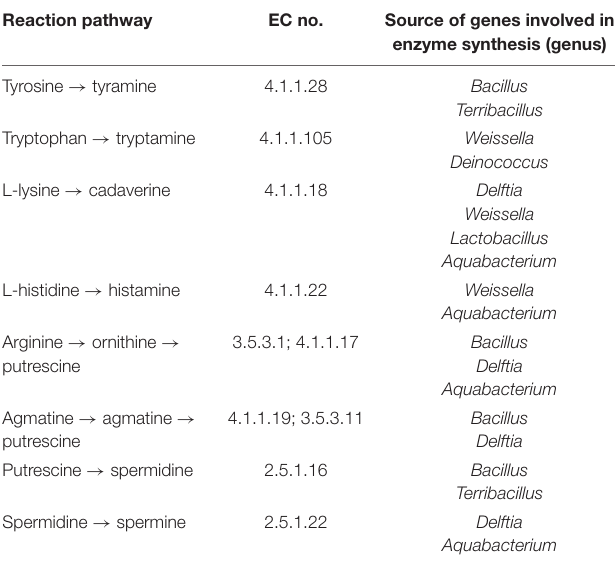
TABLE 1 | The source statistics of enzymes in metabolic pathways of biogenic amines. Reaction pathway EC no. Source of genes involved in enzyme synthesis (genus) Tyrosine → tyramine 4.1.1.28 Bacillus